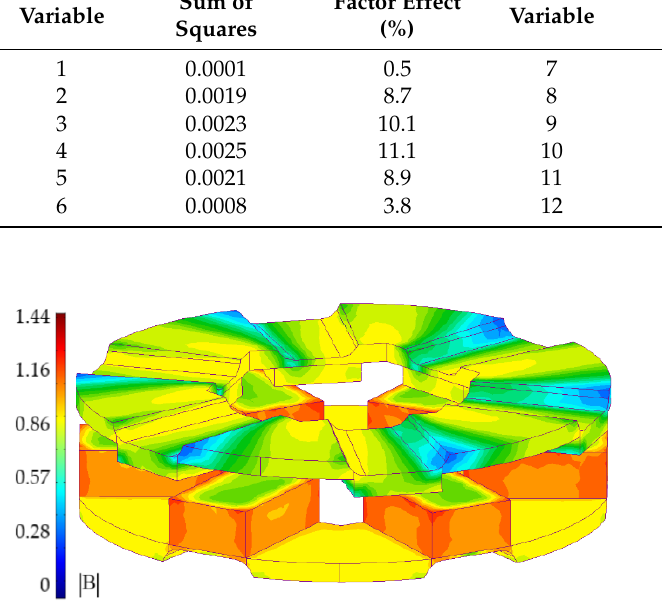
Figure 8. Taguchi optimal design with the distribution of magnetic flux density. Table 5. Simulation results of Taguchi optimization.